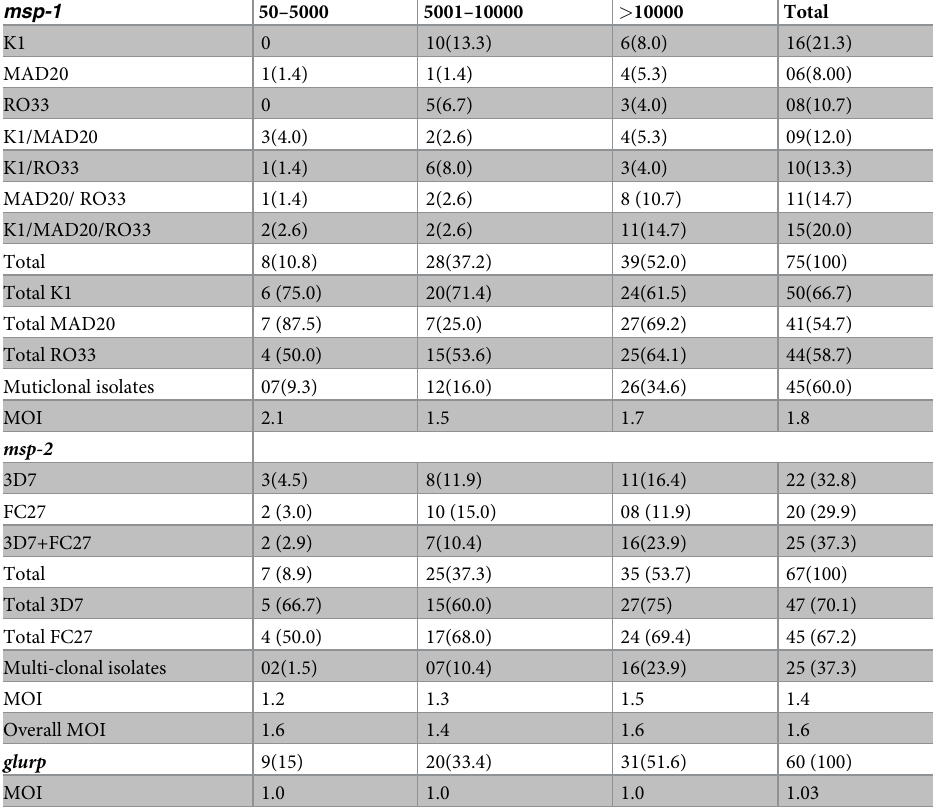
Table 6. Distributions of msp- 1 (blocks-2), msp-2 (block-3) and glurp RII allelic types among parasitaemia groups in the study